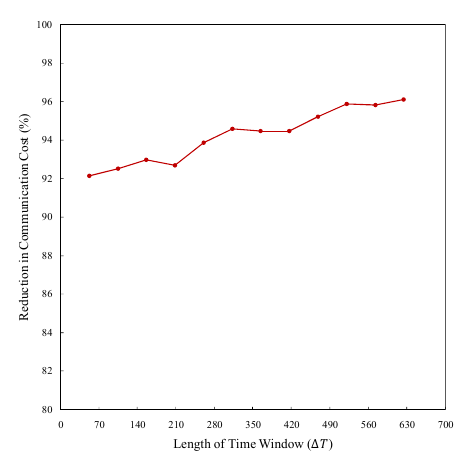
Figure 11. Reduction in communication overhead for different values of (cid:2722)(cid:2176)